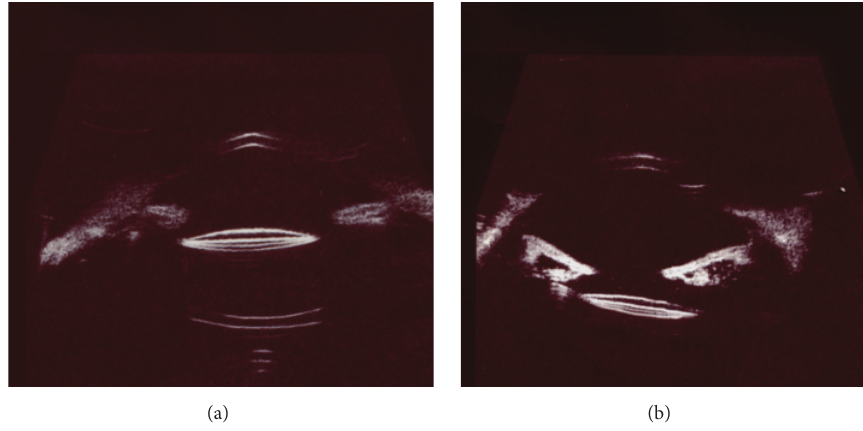
Figure 1: UBM scanning of postoperative lens position. (a) A well centered lens. (b) Lens